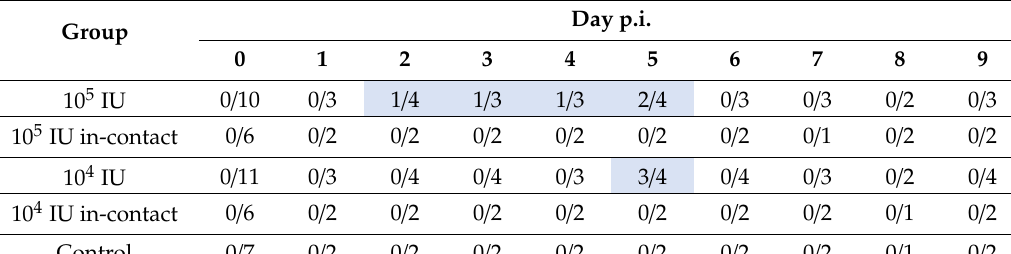
Table 3. Detection of viremia in WNV-challenged and in-contact hatchling crocodiles by inoculation of C6 / 36 cells with plasma (positive / tested).